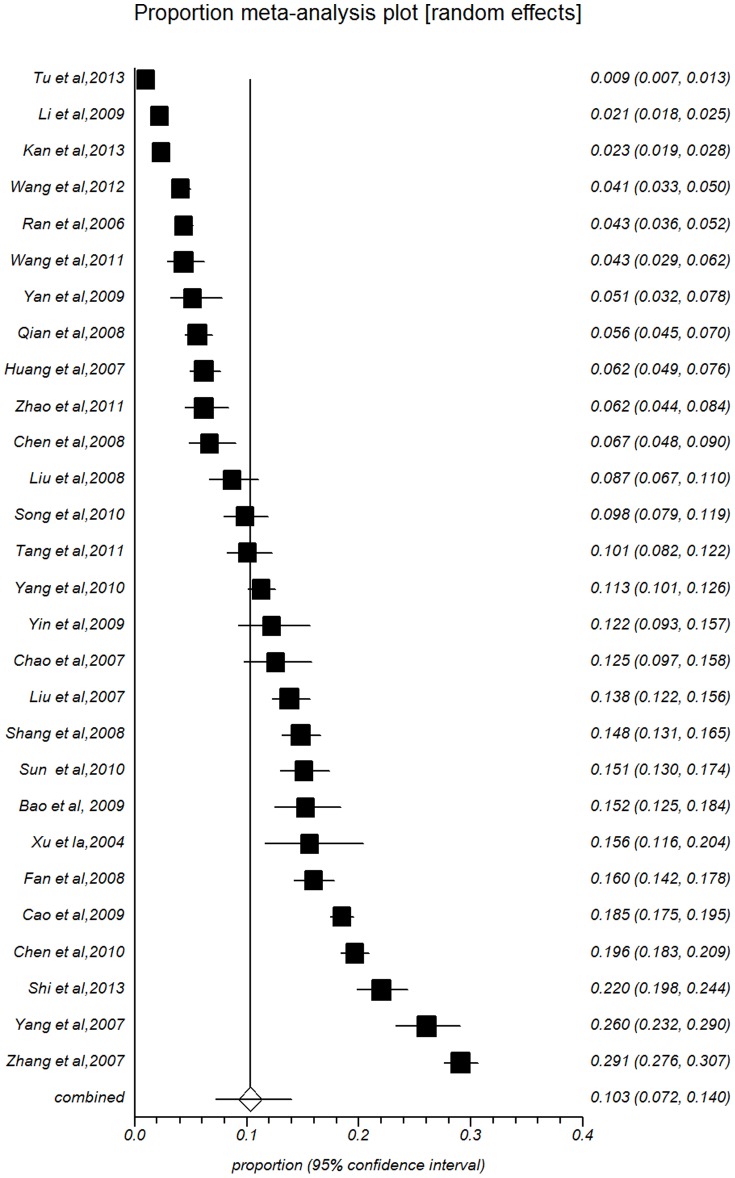
Forest plot of prevalence of suicidal ideation for female.